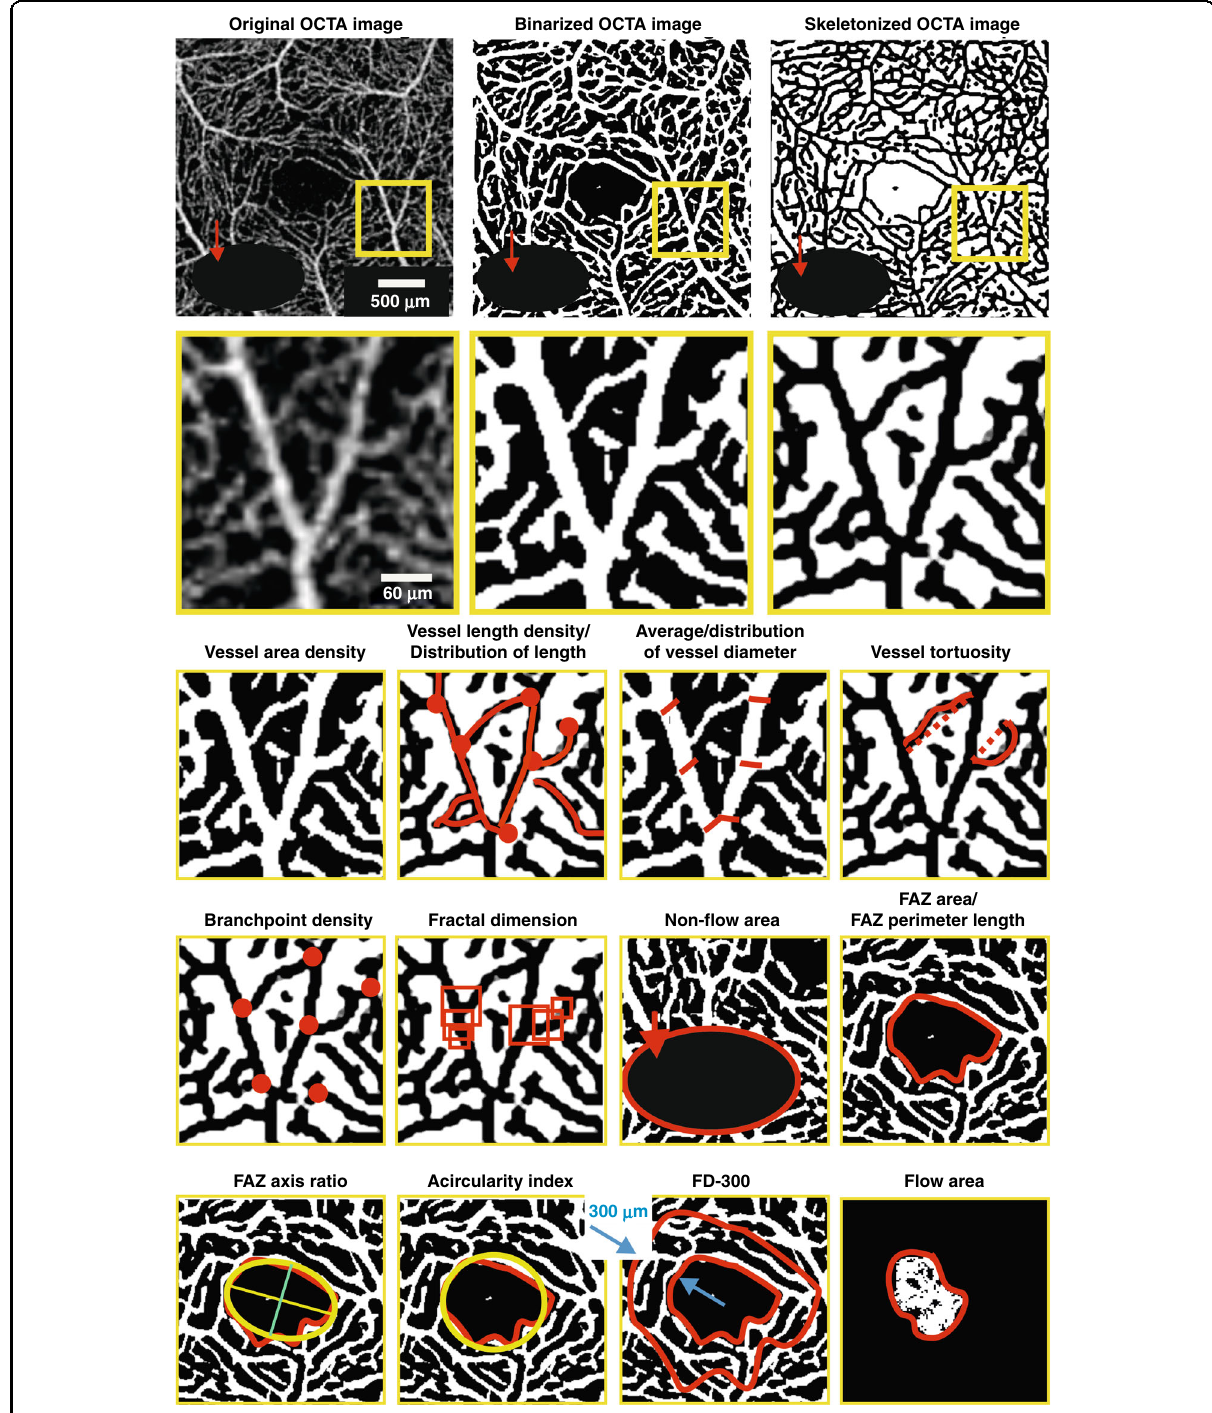
Fig. 8 OCTA microvascular metrics. Visual representation of recommended OCTA-based retinal microvascular metrics as de fi ned in Table